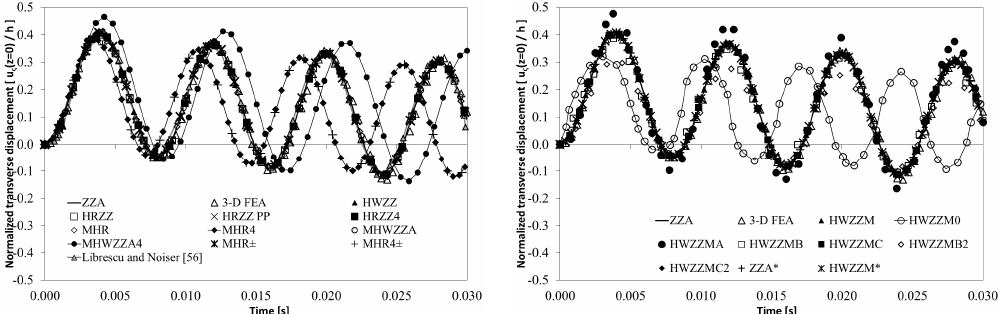
Figure 12. Case i2: Normalized transverse displacement of a simply supported laminated plate under an exponential blast pulse loading ( L x/ h = 14.941).